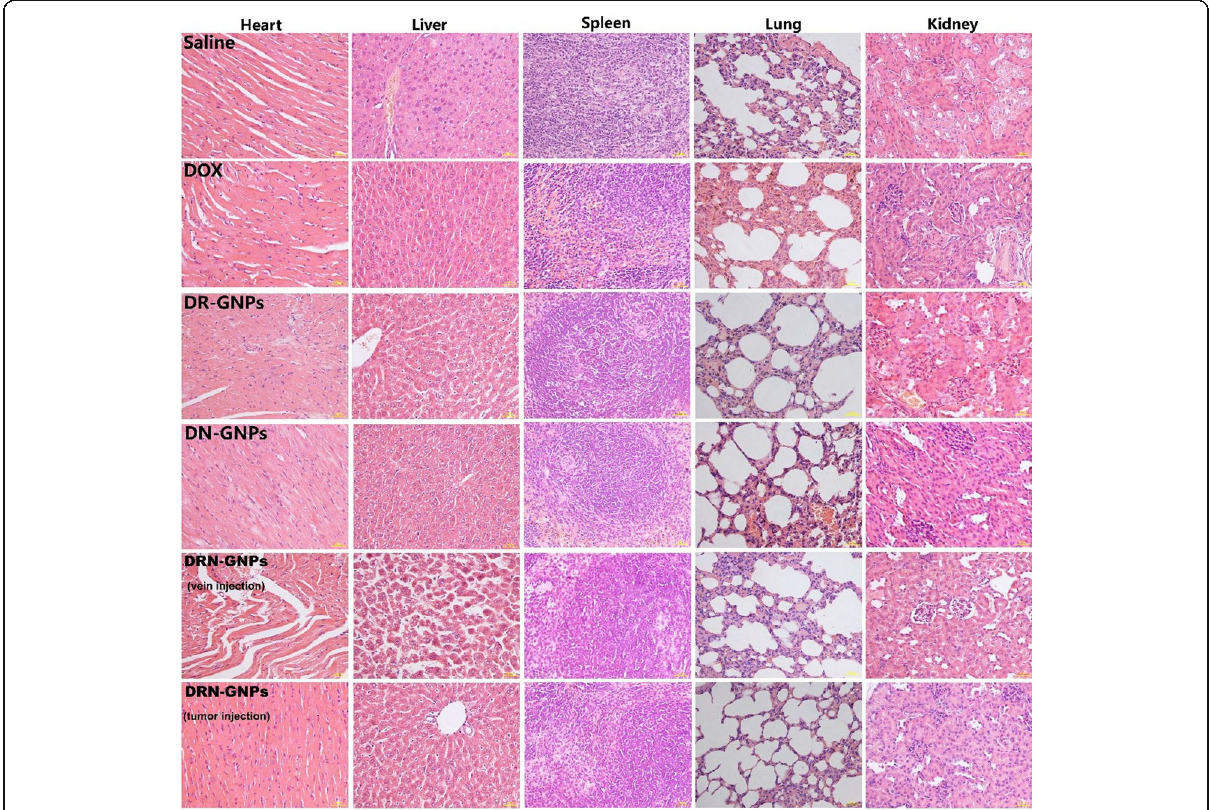
Fig. 9 The histological images of the main organs (heart, liver, spleen, lung, and kidney) of the mice after treated with saline, free DOX, DR-GNPs, DN-GNPs, and DRN-GNPs (tumor injection and intravenous